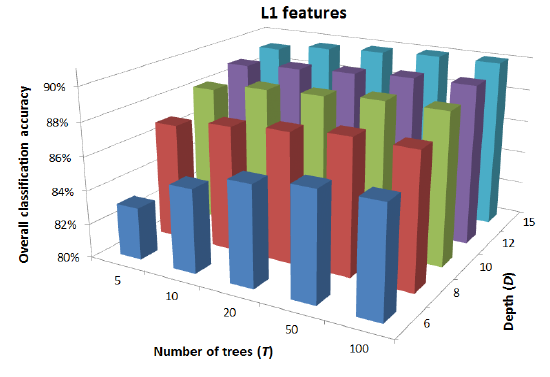
Figure 6. Overall classification accuracy in regard to random forest classifier parameters ( T and D